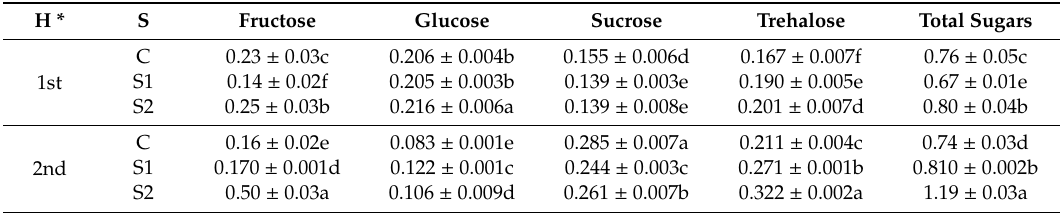
Table 4. Composition in sugars (g / 100 g fw) of Centaurea raphanina subsp. mixta leaves in relation to